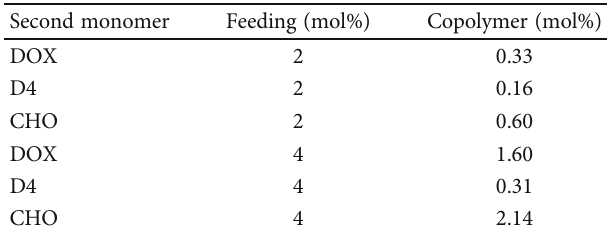
Table 3: Cationic copolymerization of TOX and the second